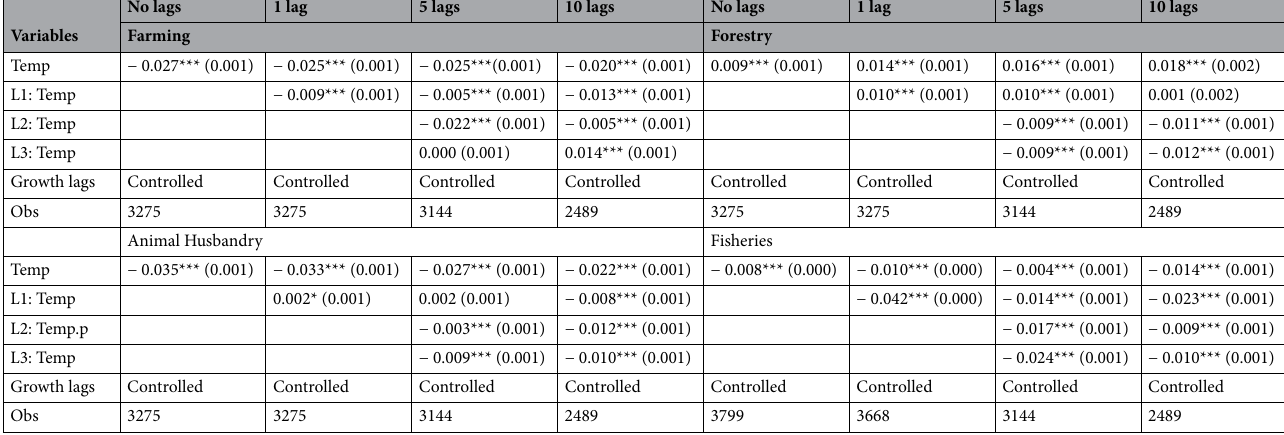
Table 4. Estimated impact of average temperature on economic growth across agricultural sectors. ***, **, * indicate significant at the statistical level of 1%, 5%, and 10%, respectively.